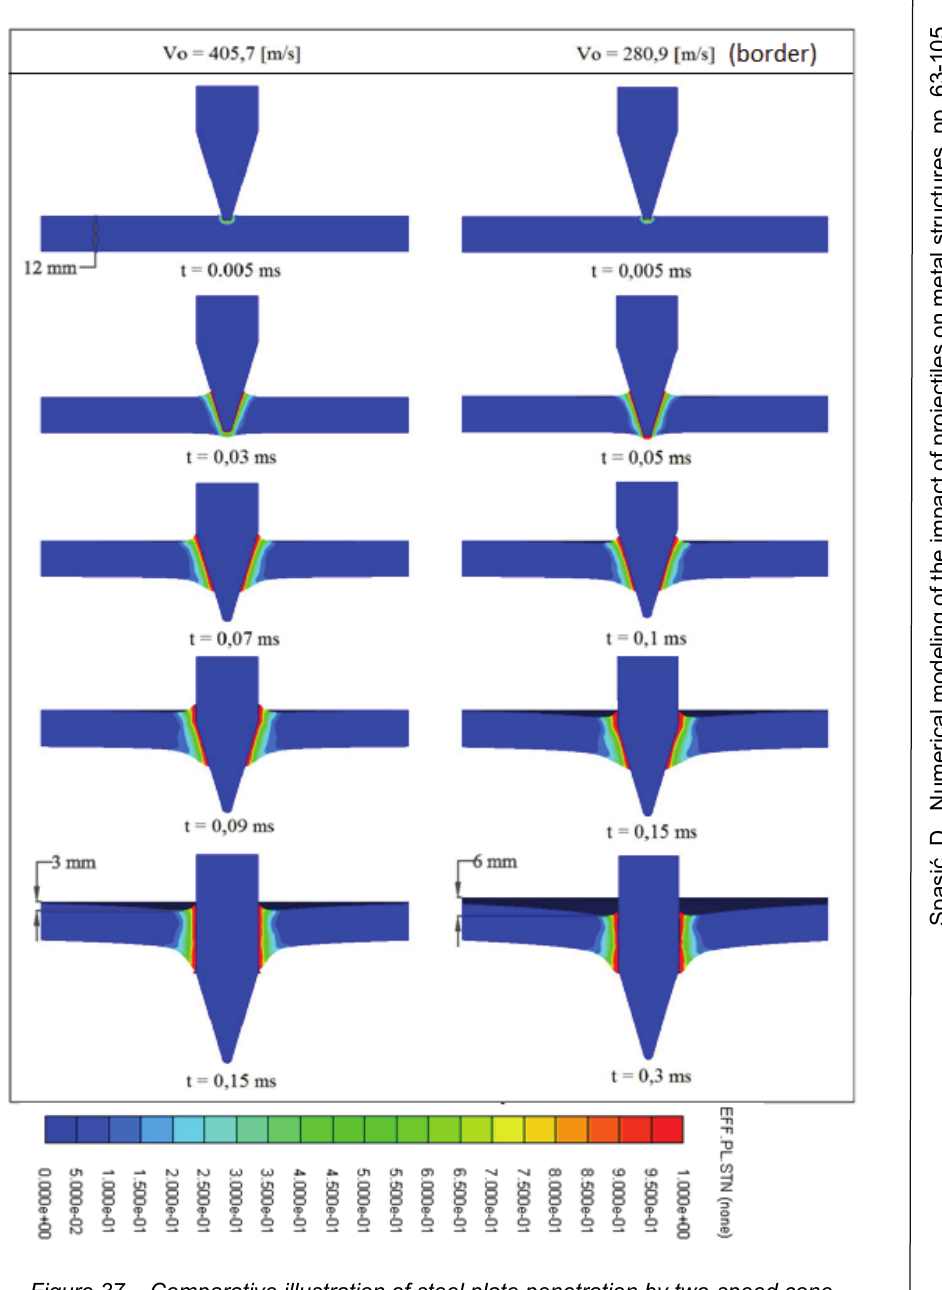
Figure 37 – Comparative illustration of steel plate penetration by two-speed cone projectiles, FEM